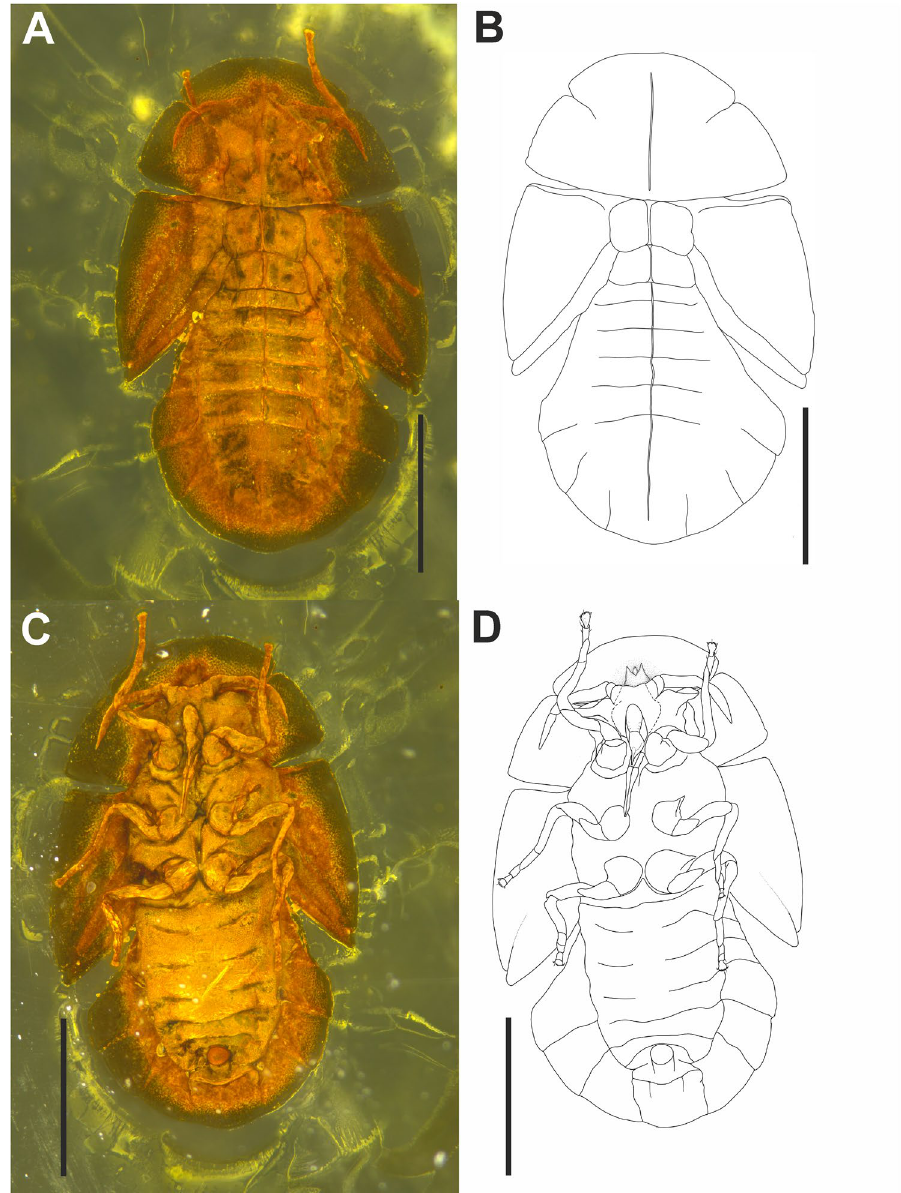
Figure 3. Megalophthallidion sp. (MAIG 6688), nymph. ( A ) Photo of body, dorsal side and ( B ) drawing of body dorsal side; ( C ) photo of body dorsal side and ( D ) drawing of body ventral side. Scale bars: 0.5 mm ( A–D